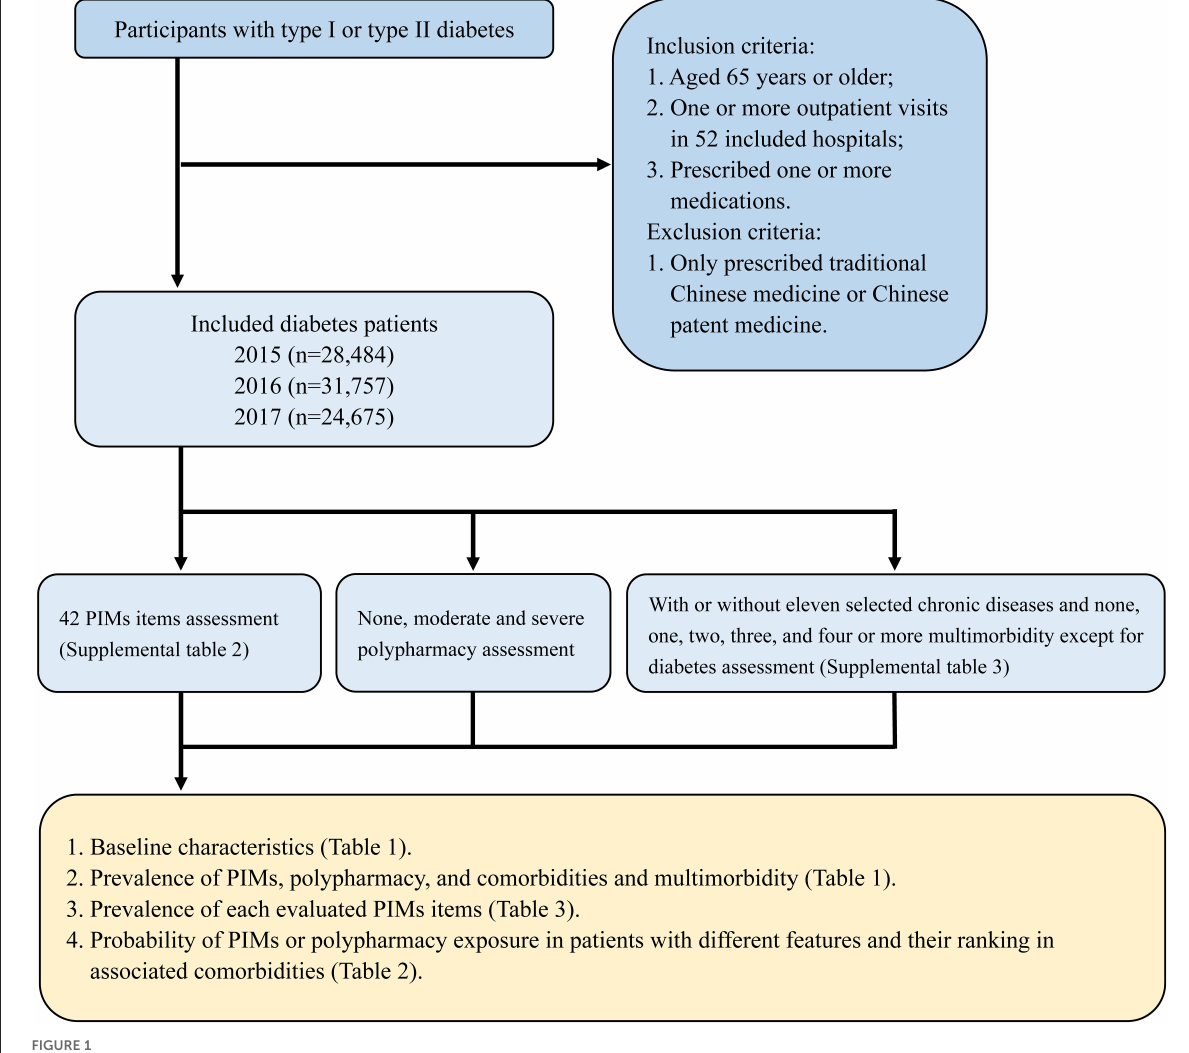
FIGURE1 The flowchart of prevalence of potentially inappropriate medications (PIMs) and association with comorbidities in older adults with diabetes in an outpatient visitation setting which including the selection criteria of participant, investigating content, the main results and relevant tables.